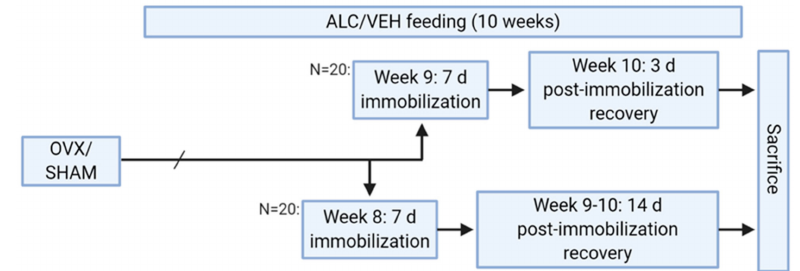
Figure 1. Schematic of study design. OVX: ovariectomy, SHAM: sham surgery, ALC: alcohol-containing diet, VEH: control